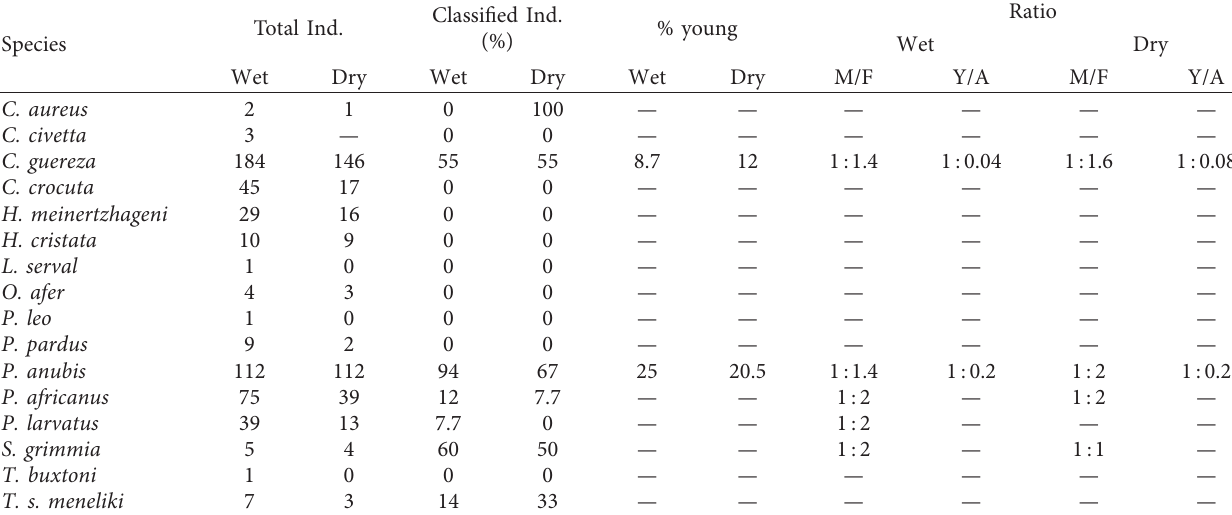
F � female; M � male; Ind. � individuals; Y �